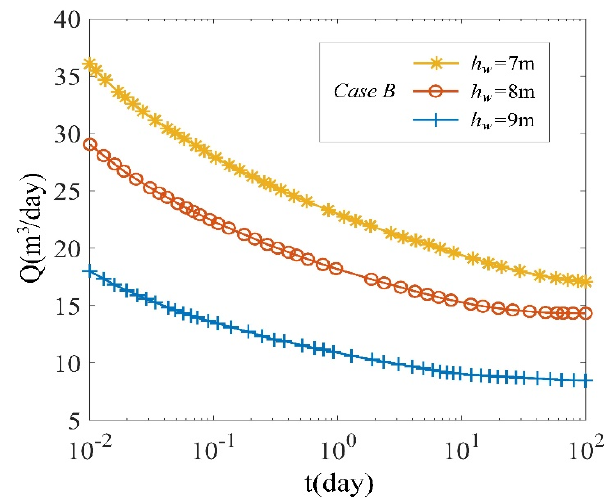
Figure 5. Dynamic development of the flow rates with different hydraulic heads inside the pumping well.